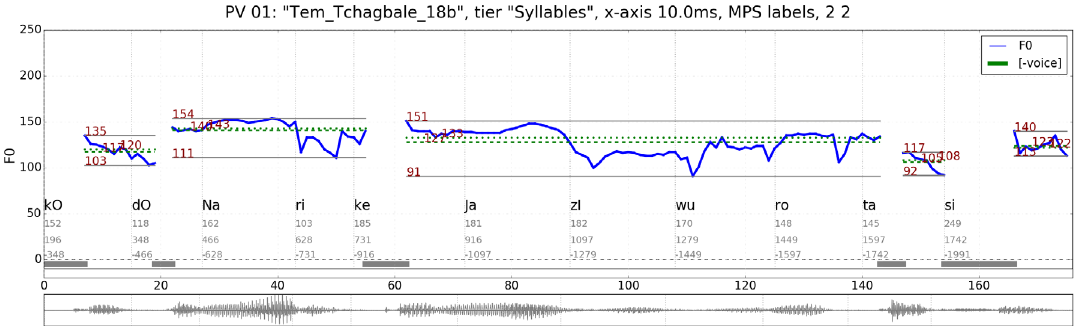
Figure 10: Tem (Niger-Congo, Gur) tone patterns in context: “kodóngariké nyazi wúro ta sí” (laughing as though the king were not dead).